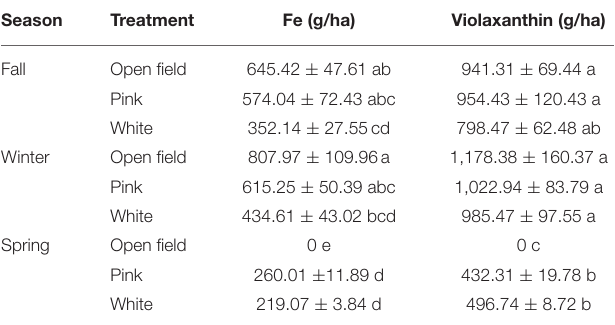
TABLE 7 | Iron and violaxanthin content of red amaranth under colored poly-net house, white poly-net house, and open field conditions in Taiwan during 2020–2021.